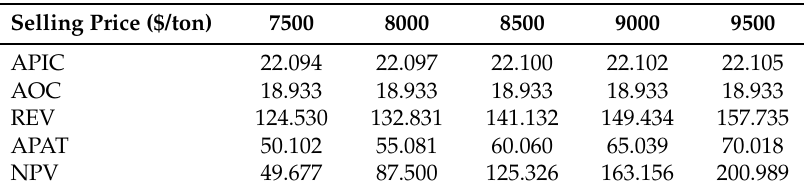
Table 8. The effect of biodiesel selling price on economic variables in Optimization Strategy I, including annual project investment cost (APIC), annual operating cost (AOC), revenue (REV), annual actual profit after tax (APAT), and net present value (NPV).